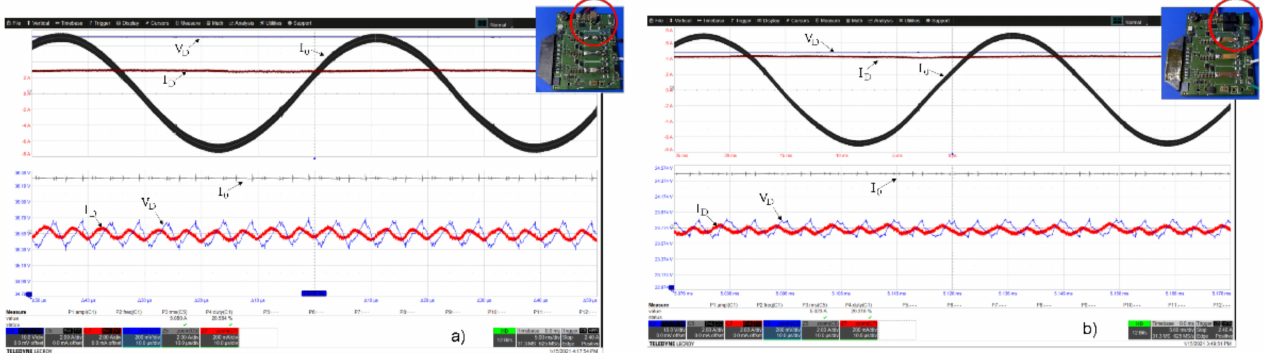
Figure 13. Switching waveform with dead time of 21 ns at I 0 = I a = 5 Arms V D = 36 V, 100 kHz of the switching frequency ( a ) C f ceramic equal to 22 µ F, ( b ) C f tantalum equal to 30 µ F. Upper waveforms V D = 10 V/div, I D = 2 A/div, I 0 = 2 A/div, t = 5 ms bottom zoomed waveforms V D = 200 mV/div, I D = 200 mA, I 0 = 2 A/div, t = 10 µ